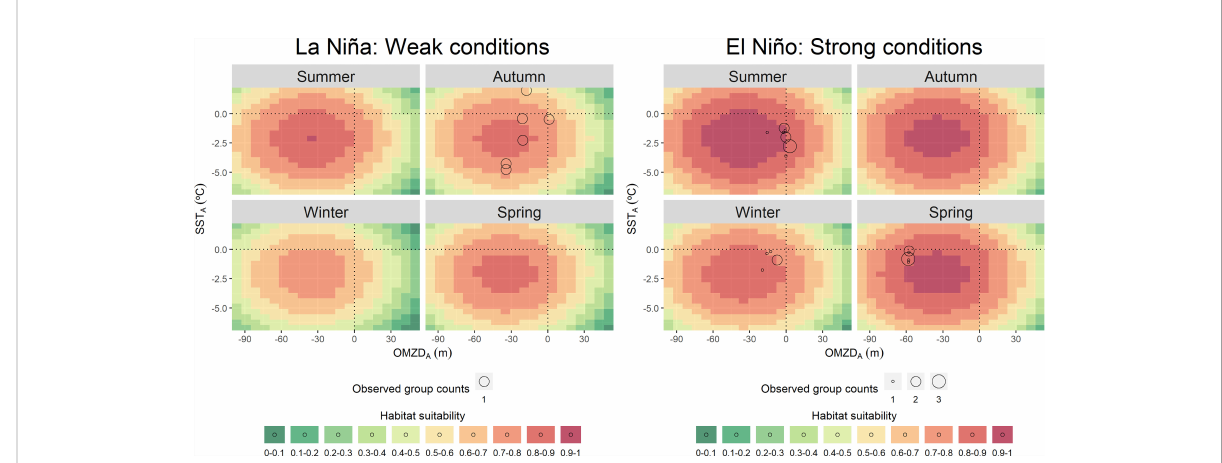
FIGURE 3 Predicted values of common dolphin ( Delphinus delphis spp.) habitat suitability for a theoretical environmental space during La Niña and El Niño conditions, based on the covariates included in the best model: the oxygen minimum zone depth spatial anomaly (OMZD A ) and the remotely